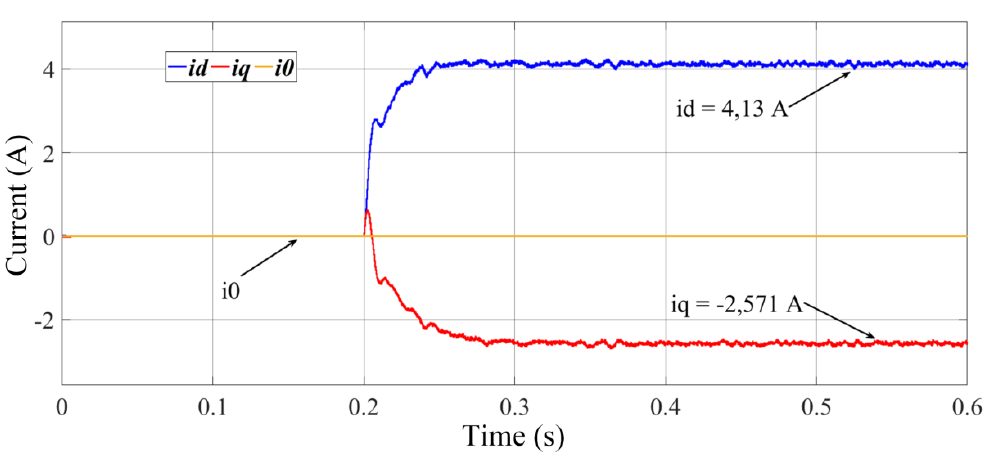
Figure 11. Voltage (upper, 10 kV/div) and current (lower, 5 A/div) imposed to TUT, F p = 0.85 inductive. Horizontal axis: 5 ms/div. Figure 12. Fractional apparent power (S) supplied by the inverter, 500 VA/div. Horizontal axis: 100 ms/div.